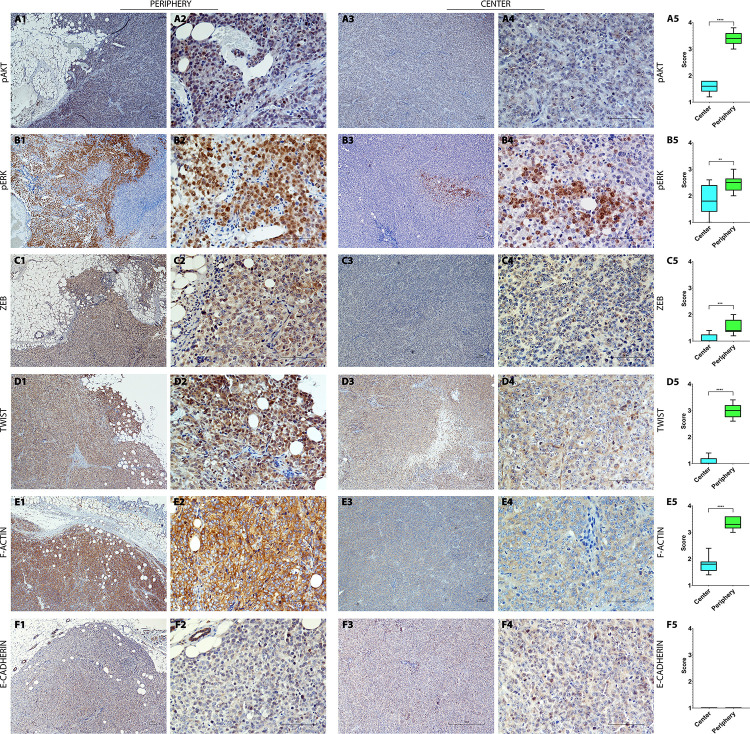
Overview of immunohistochemical characterization (A1-A5 to F1-F5) of the HEK-EBNA293-VEGF-D cells xenotransplanted in SCID mice that supports an invasive phenotype on the periphery of the tumor.A1-A5: tumor periphery displaying an increased number (mean score = 3.38) of neoplastic cells with nuclear immunolabeling for pAKT (A1-A2, 4x, 20x) compared to those (mean score = 1.60) at the tumor center (A3-A4, 4x, 20x) as displayed in the box and whisker plots (A5), showing mean values and maximum and minimum values. Significant differences (p ≤ 0.05, t student test) are indicated by asterisks (**** p ≤ 0.0001). B1-B5: increased number (mean score = 2.48) of pERK nuclearly immunolabeled neoplastic cells at the tumor periphery (B1-B2,4x, 20x) compared to (mean score = 1.86) tumor central areas (B3-B4, 4x, 20x) as displayed the box and whisker plots (B5), showing with mean values and maximum and minimum values. Significant differences (p ≤ 0.05, t student test) are indicated by asterisks (** p ≤ 0.01). C1-C5: tumor periphery displaying an increased number (mean score = 1.52) of neoplastic cells with nuclear immunolabeling for ZEB-1 (C1-C2, 4x, 20x) compared to those (mean score = 1.00) at the tumor center (C3-C4, 4x, 20x) as showed in the box and whisker plots (C5), showing mean values and maximum and minimum values. Significant differences (p ≤ 0.05, t student test) are indicated by asterisks (*** p ≤ 0.001). D1-D5: increased number (mean score = 3.00) of TWIST-1 nuclearly immunolabeled neoplastic cells at the tumor periphery (D1-D2,4x, 20x) compared to (mean score = 0.96) tumor central areas (D3-D4, 4x, 20x) as displayed in the box and whisker plots (D5), showing mean values and maximum and minimum values. Significant differences (p ≤ 0.05, t student test) are indicated by asterisks (**** p ≤ 0.0001). E1-E5: increased number of membranous to cytoplasmic F-actin immunopositive cells (mean score = 3.32) at the tumor periphery (E1-E2, 4x, 20x) compared to (mean score = 1.78) central tumor areas (E3-E4, 4x, 20x) as displayed in the box and whisker plots (E5), showing mean values and maximum and minimum values. Significant differences (p ≤ 0.05, t student test) are indicated by asterisks (**** p ≤ 0.0001). F1-F5: rare cells with a weak cytoplasmic to membranous E-cadherin immunolabeling found both at the tumor center (mean score = 0.22) and periphery (mean score = 0.20) without differences as displayed in the box and whisker plots (F5), showing mean values and maximum and minimum values. Significant differences (p ≤ 0.05, t student test).